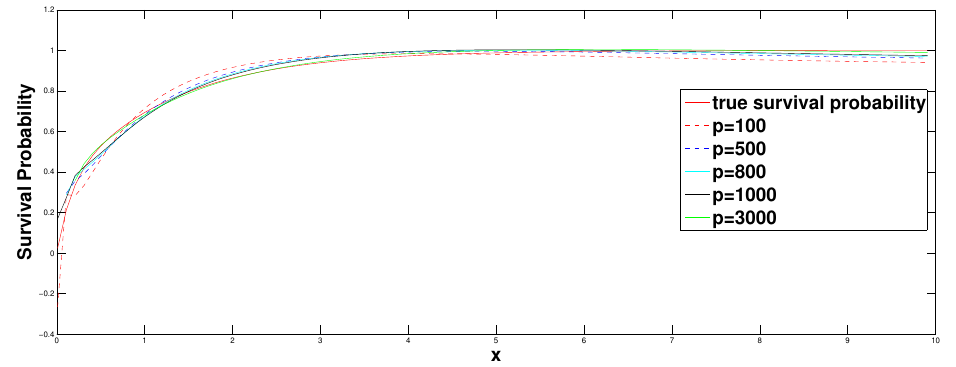
Figure 2. Φ p ( x ) with sample size n = 30,000 and p =